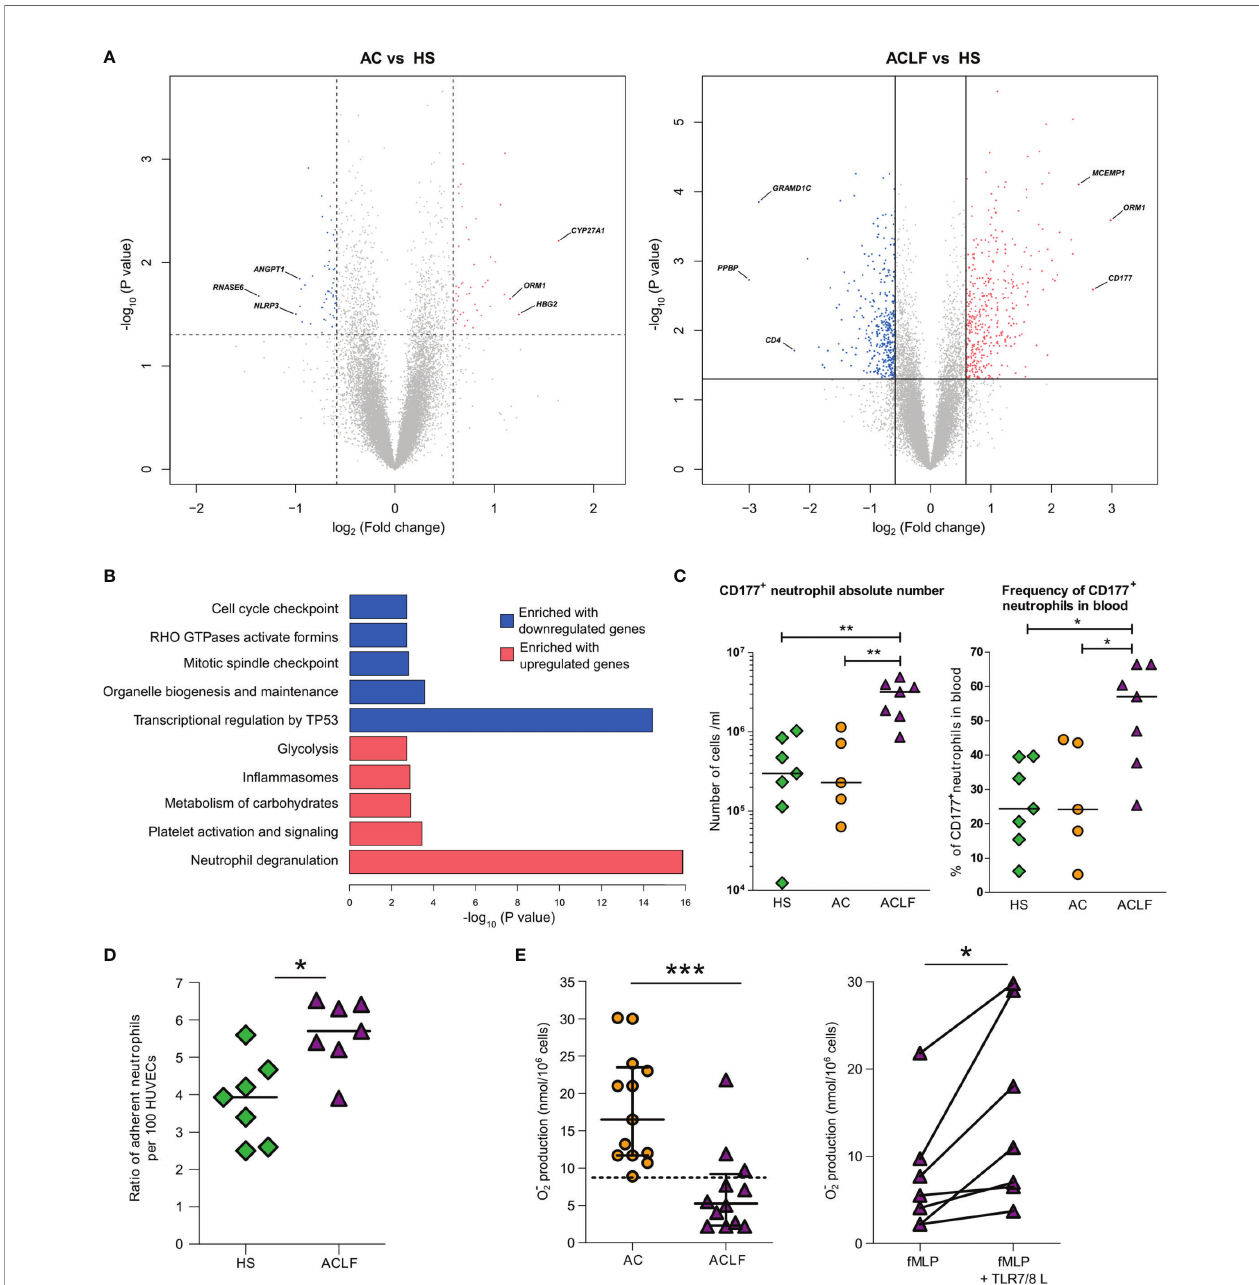
FIGURE 4 | Unique phenotype of neutrophils from patients with ACLF. (A) Volcano plots of differential neutrophil gene expression between AC and HS and ACLF versus HS. There were fi ve healthy subjects (HS), fi ve patients with advanced cirrhosis (AC), and fi ve patients with ACLF. Between-group comparisons were performed using unpaired Student ’ s t -test. CD177 was the most upregulated gene in ACLF versus HS. (B) Enrichment of Reactome data sets with differentially expressed genes between ACLF and HS. (C) Absolute number and frequency of CD177 + neutrophils in blood from HS (green diamonds, n=7), patients with AC (orange circles, n=5) and patients with ACLF (purple triangles, n=7). (D) Increased adhesion to HUVECs of neutrophils from ACLF patients relative to neutrophils from HS. Neutrophils from HS (n=7) and patients (n=7) were freshly isolated; their adherence to HUVECs was measured using fl ow cytometry as the ratio of CD66b + neutrophil per HUVEC. (E) Defective superoxide production in neutrophils from patients with ACLF is restored by a TLR7/8 agonist. Freshly isolated neutrophils from 13 patients with ACLF and 13 patients with AC were stimulated with fMLP (1 µM) and respiratory burst was monitored using the cytochrome c reduction assay. In seven patients, neutrophils were pre-treated with the TLR7/8 agonist CL097 (2 µg/ml) for 10 min before stimulation with fMLP. During the same period, median [IQR] superoxide production in neutrophils from healthy subjects was 19.6 [15.4 – 27.25]. ***P <0.001; *P <0.05. HUVEC denotes human umbilical vein endothelial cell, and fMLP